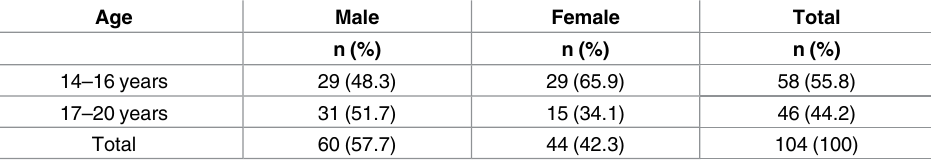
Table 1. Frequency and percentage of high school athletes categorized according to sex and